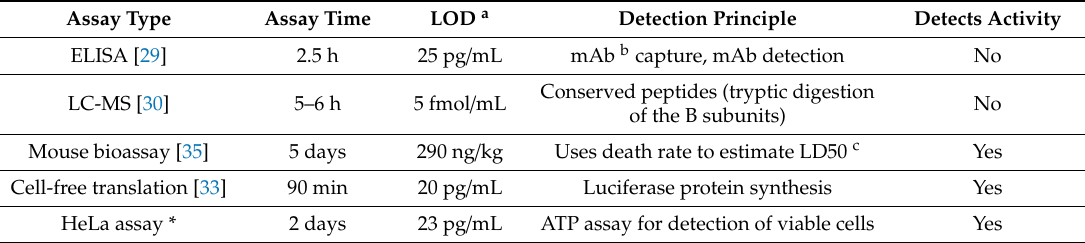
Table 1. Common tests used for